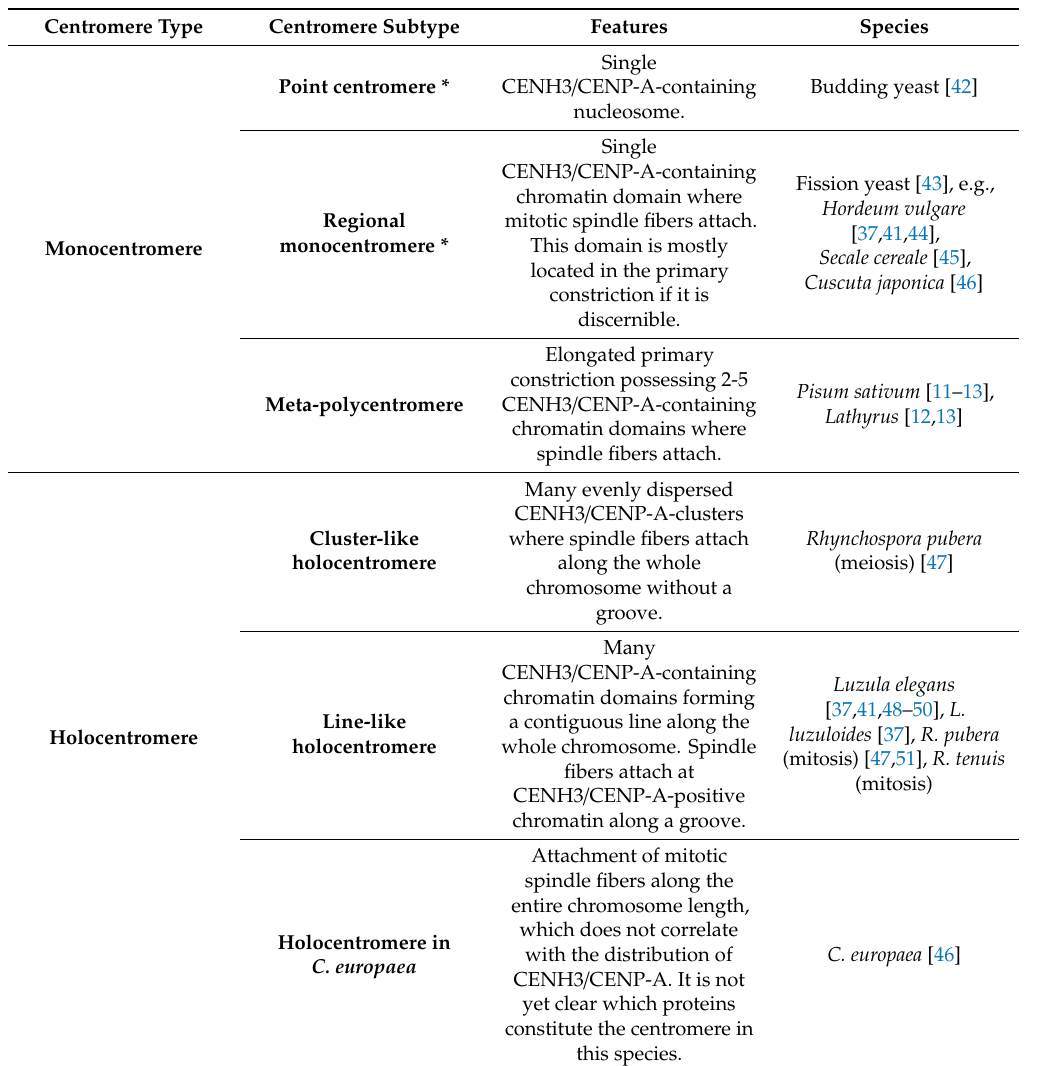
Table 1. Centromere types present in yeast and plant species classified based on the distribution of spindle fiber attachment